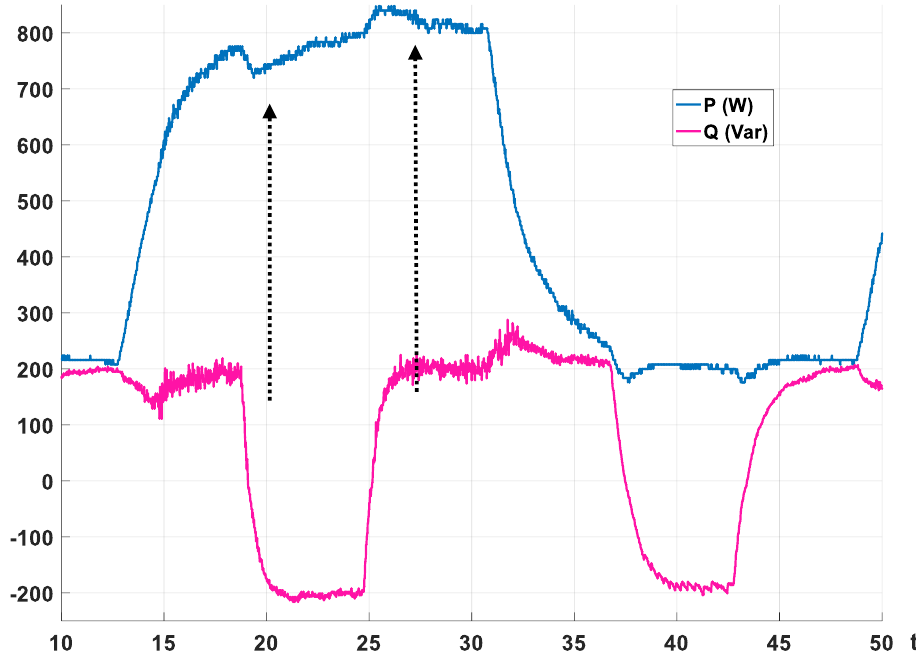
Figure 13. Response of PTMVR method (random configuration) to big step changes of P set and Q set .